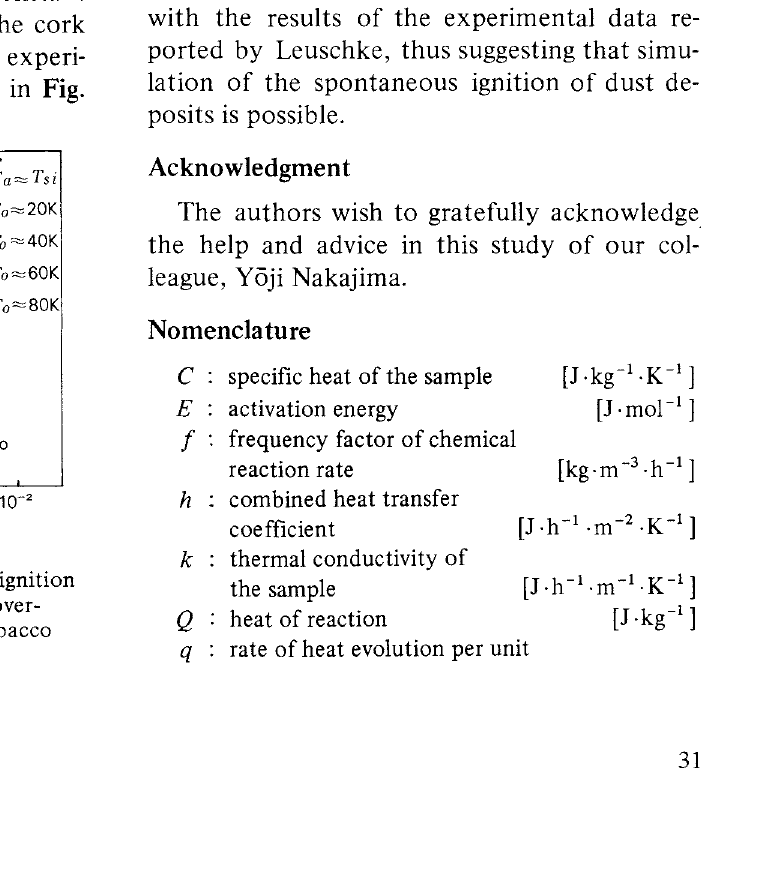
Fig. 11 The experimental induction time to ignition reported by Leuschke at different over temperatures as a function of the tobacco dust